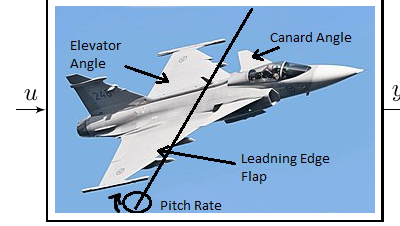
Figure 3: Example 4.3. The figure shows an open loop system of the JAS 39 Gripen fighter aircraft.